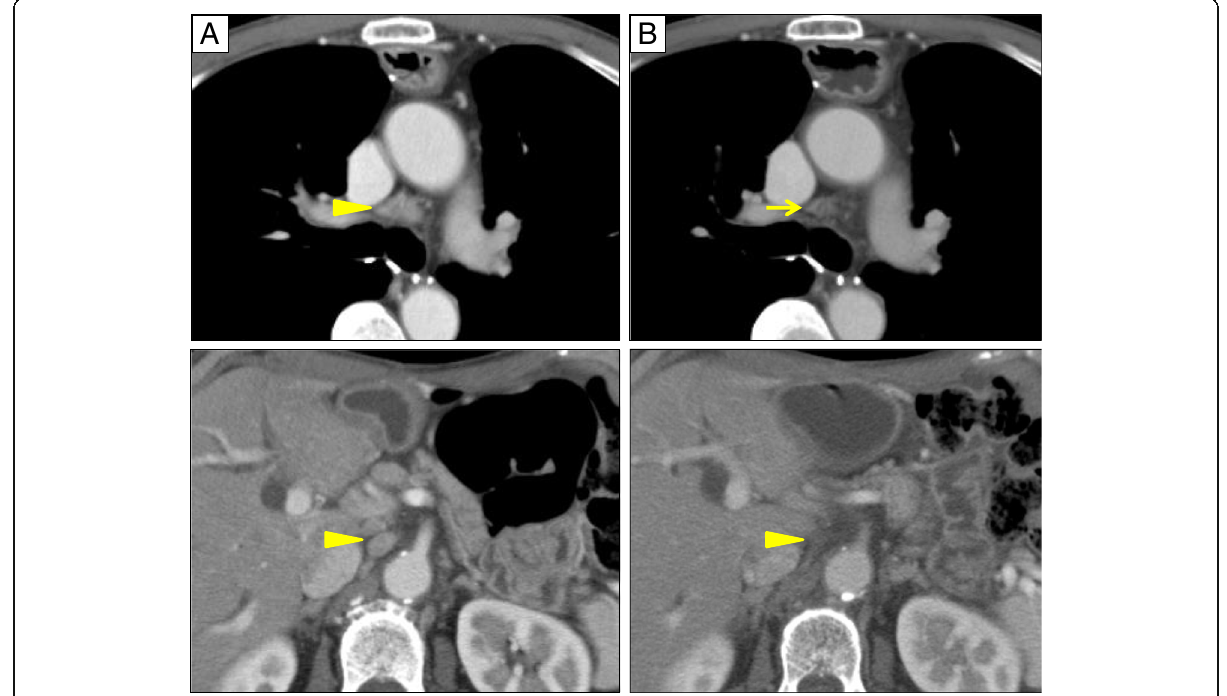
Fig. 4 CT images showing metastases in multiple mediastinal and intra-abdominal LN. a Before chemoradiation (arrowhead). b After treatment, showing mediastinal LNs decreased and intra-abdominal LN disappeared